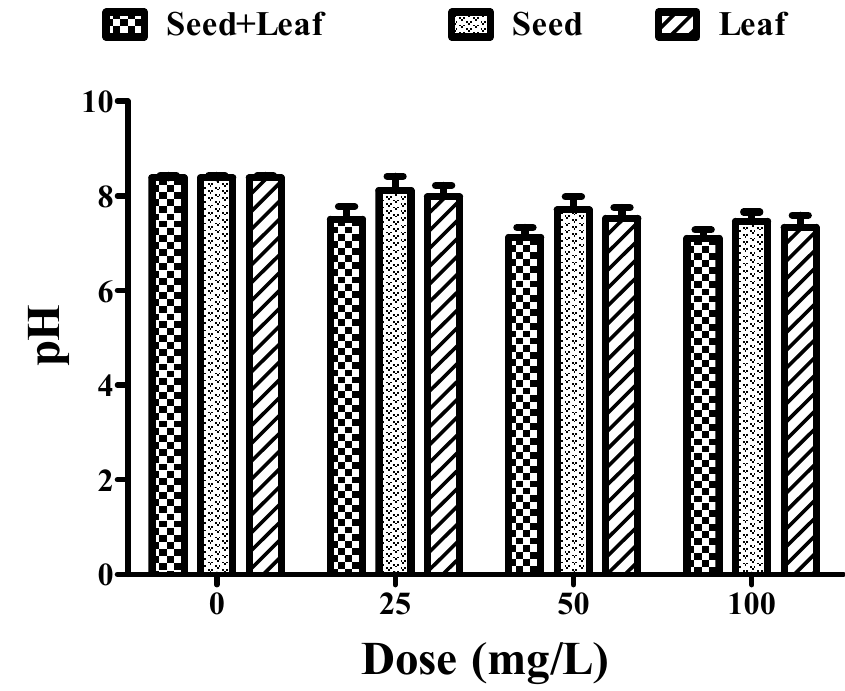
Figure 1. Comparative experimental analysis of combined (seed and leaf) and individual extracts of the Moringa oleifera plant on pH parameters of groundwater at different doses (25–100 mg/L). All the experiments were done three times in triplicates and presented as mean ± SEM (Standard Error Mean).